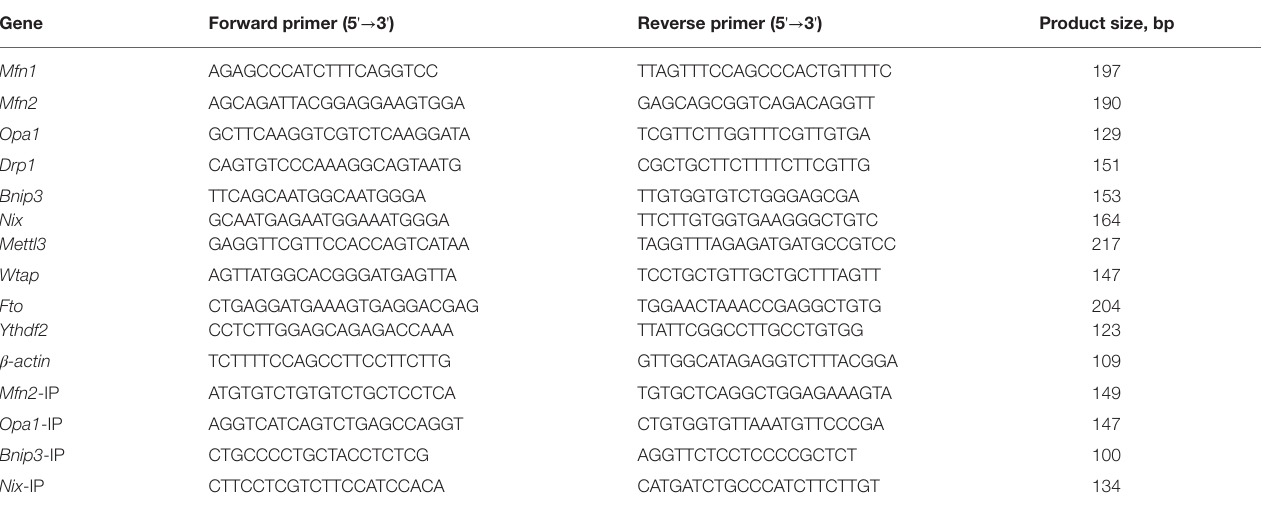
TABLE 2 | Primer sequences for qPCR